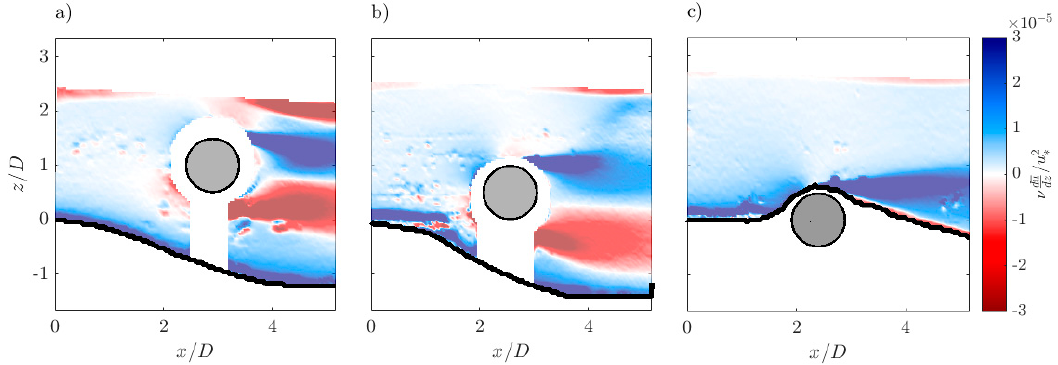
Figure 9. Dimensionless viscous stresses on a vertical plane in ( a ) Run 1, ( b ) Run 2 and ( c ) Run 3.